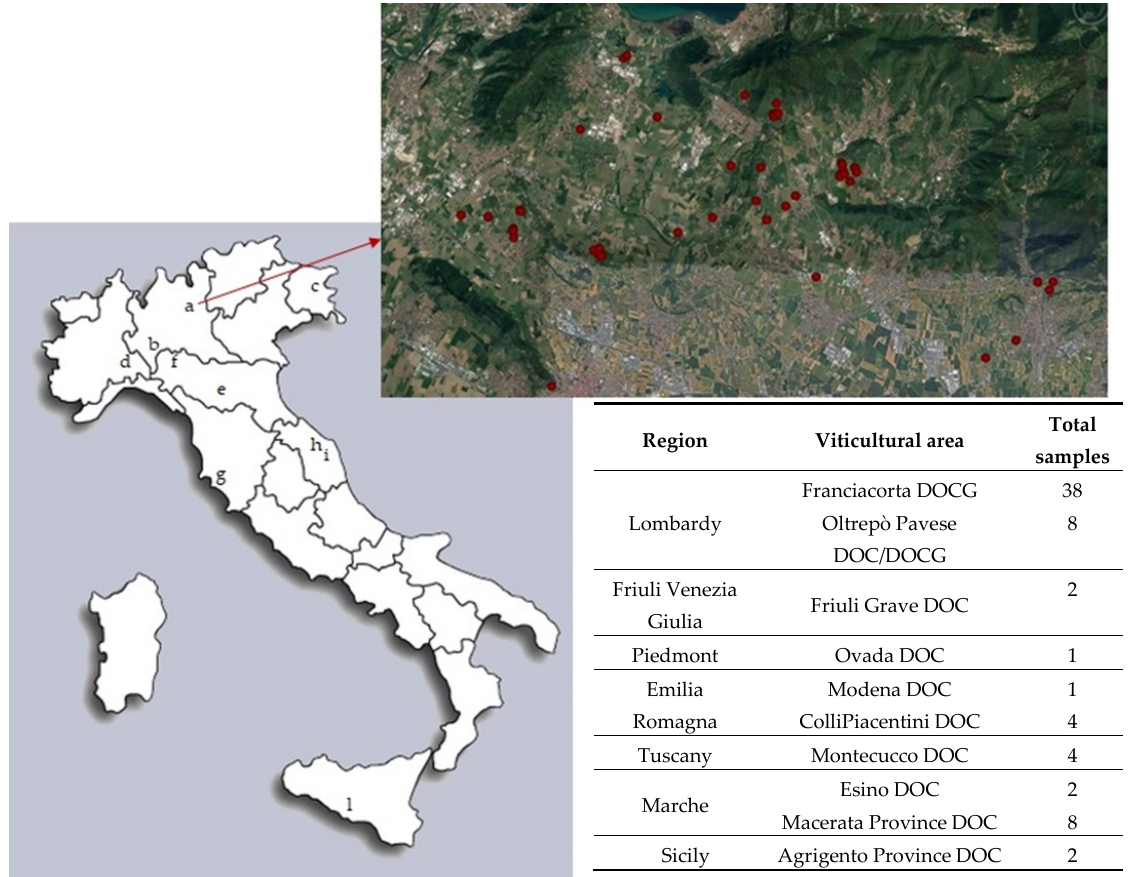
Figure 2. Map of locations of different wine growing areas where samples has been collected. For Franciacorta DOCG a deeper level of detail is shown in relation to the high number of vineyards investigated.